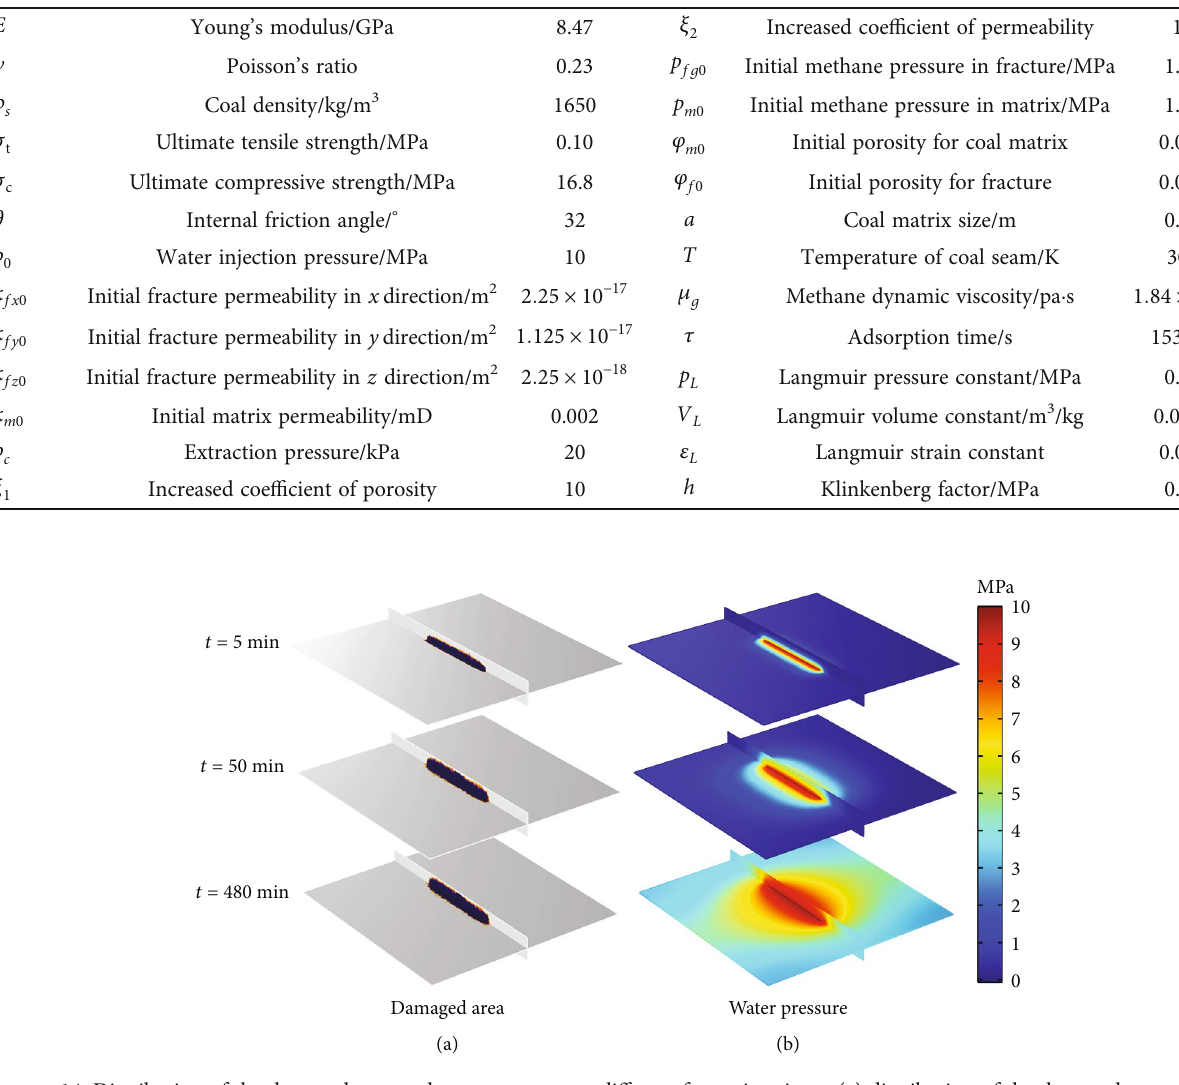
Figure 14: Distribution of the damaged area and water pressure at di ff erent fracturing times: (a) distribution of the damaged area and (b) distribution of water